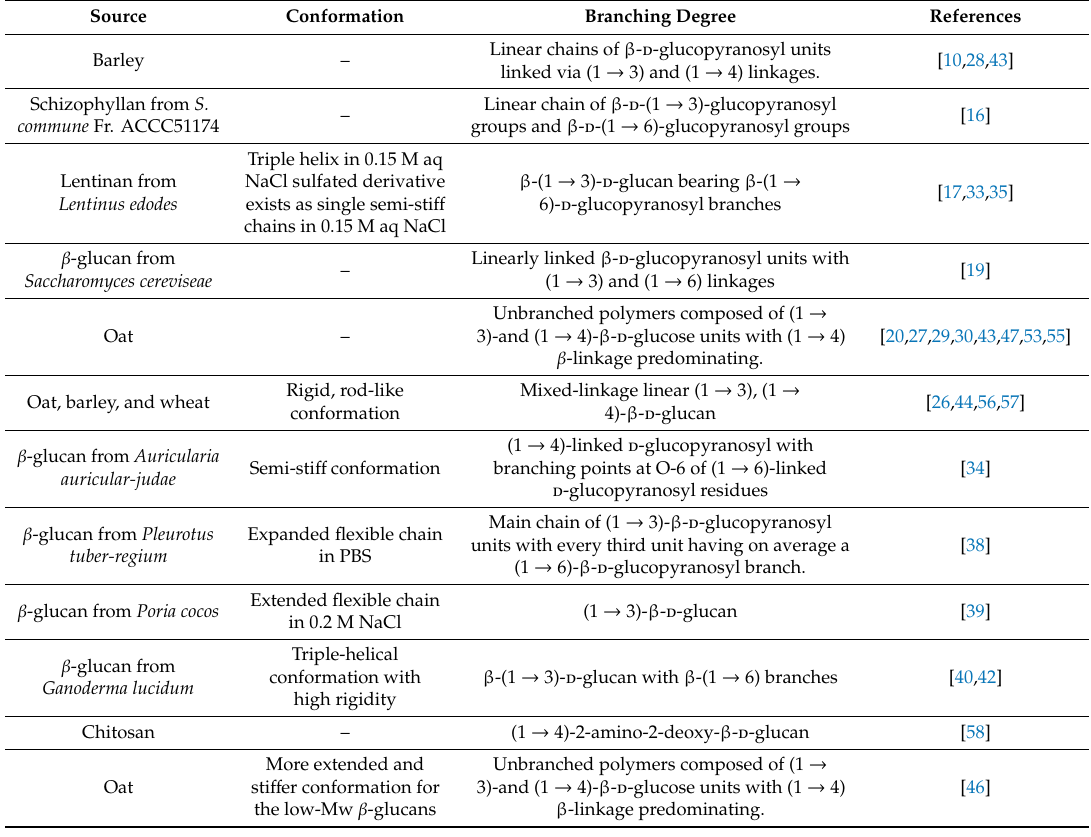
Table 2. Conformation and branching degree of β -glucan from di ff erent